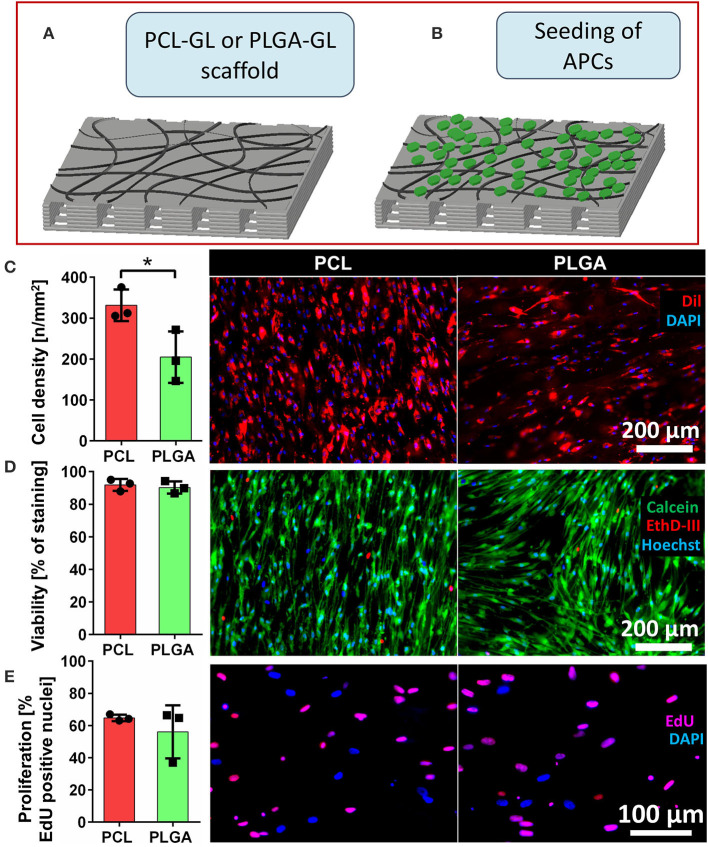
In vitro cellularization of scaffolds and functional assessment. (A,B) Schematic representation of the Hybrid scaffold preparation following the specific steps: (A) step a: fabrication of the composite scaffold formed by poly(ε-caprolactone (PCL) or polylactic-co-glycolic acid (PLGA) and gelatin (GL) nanofibers, named, respectively, PCL-GL and PLGA-GL; (B) step b: seeding with adventitial pericytes (APCs) and culturing for 5 days; (C) Bar graph of cell density and representative fluorescent microscopy images of PCL and PLGA scaffolds seeded with APCs. Nuclei are stained with DAPI (blue) and cell bodies are labeled with Dil (red). (D) Bar graph of cell viability and representative images of APCs: viable cells stained with calcein (green), dead cells with EthD-III (red) and all the nuclei with Hoechst (blue) for assessment of cell viability. (E) Bar graph of cell proliferation and representative images of APCs on scaffolds [proliferating cells stained by EdU (pink) and not proliferating ones with DAPI (blue)]. Values are means ± SD, N = 3 biological replicates, each one with 3 technical replicates. *P < 0.05, vs. PLGA-scaffold.